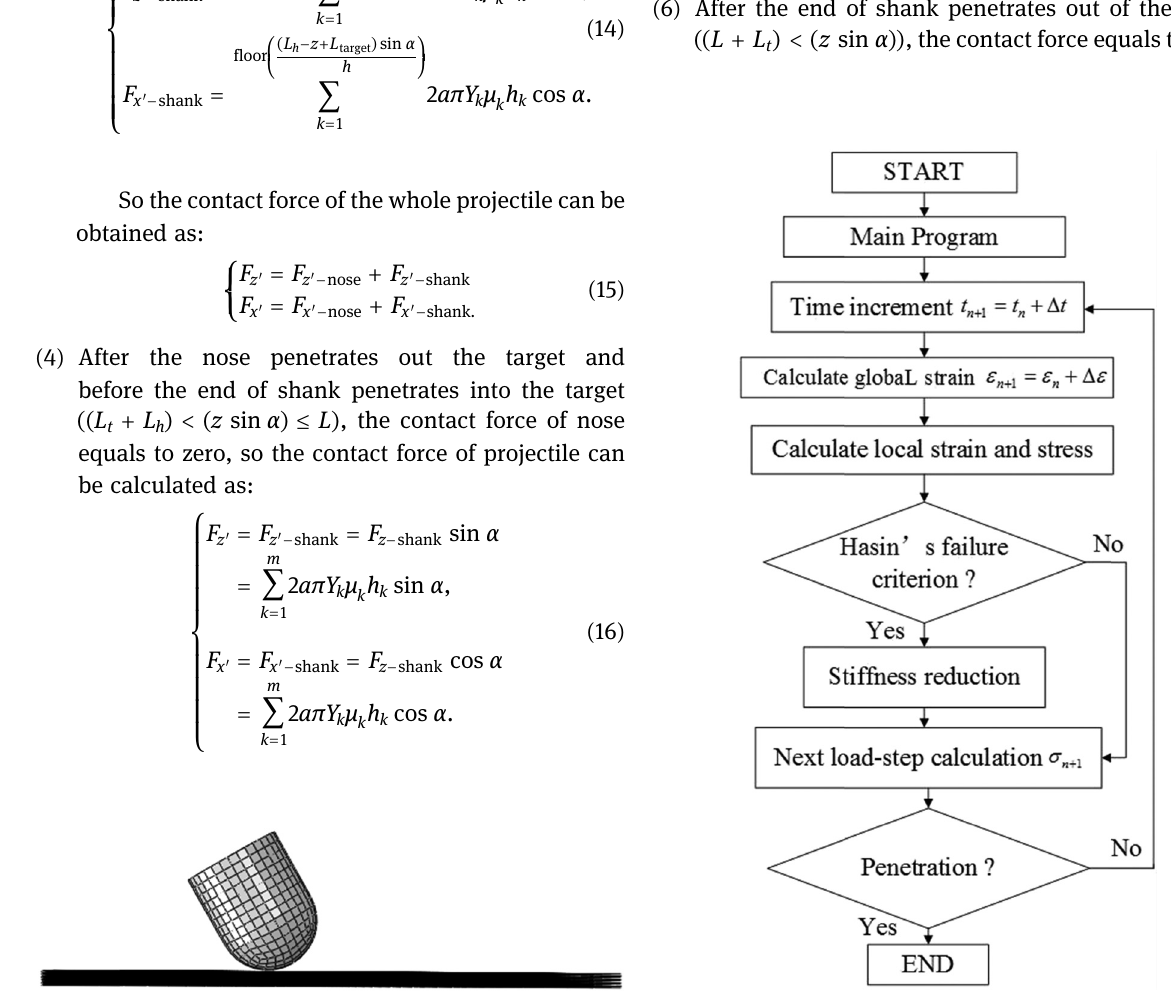
Figure 3: Oblique impact simulation model. Figure 4: Flow chart of simulation in